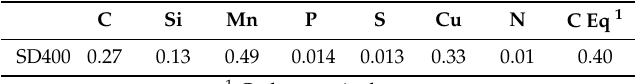
Table 2. As for the sand, ISO 679-compliant sand was used. Table 1. Chemical composition of steel bar (% mass).